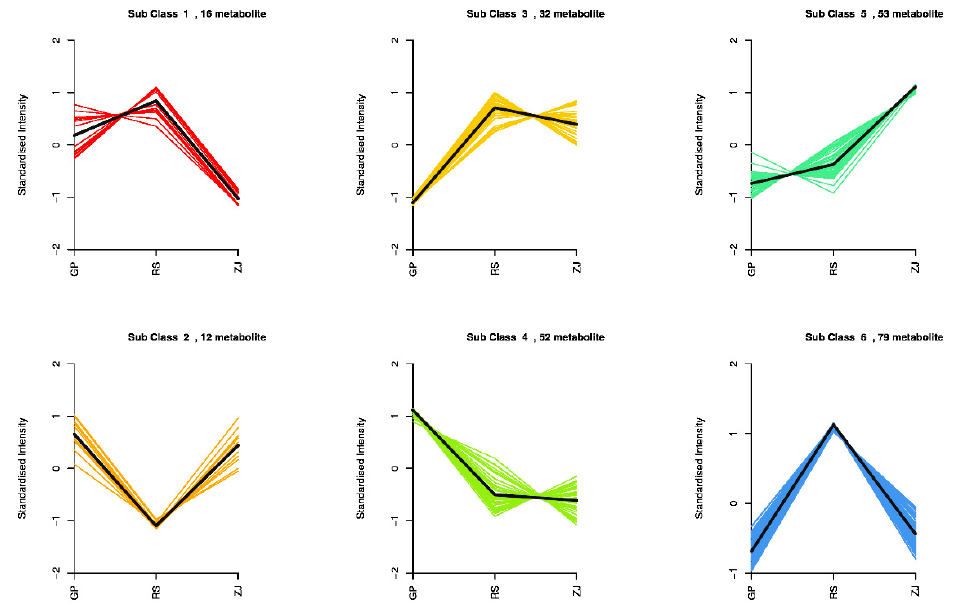
Figure 8. The K means analysis of different metabolites. The horizontal coordinate represents the sample name, and the vertical coordinate represents the standardized metabolite relative content. The Sub Class represents the number of metabolite classes with the same trend of change.